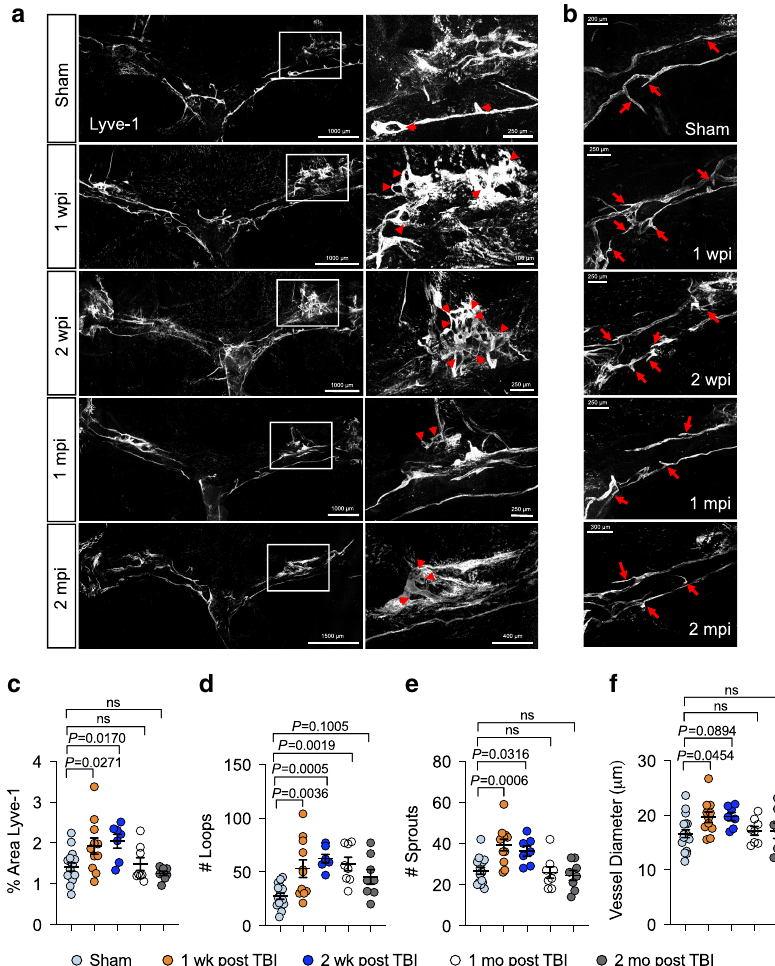
Fig. 2 TBI causes changes in meningeal lymphatic vasculature morphology. Mice received TBI or sham treatment and then meningeal whole mounts were harvested 1 week, 2 weeks, 1 month, and 2 months later. a Representative images depicting transverse sinuses (left) and meningeal lymphatic vasculature loops near lymphatic hotspots (right) and ( c ) quanti fi cation of the percent area coverage of Lyve-1 antibody staining and ( d ) the number of loops in meningeal whole mounts. Solid boxes show zoomed insets of the hotspots along the transverse sinus on the right. Red arrow heads in the insets of ( a ) denote meningeal lymphatic vasculature loops. b Representative images depicting meningeal lymphatic vasculature sprouts along the transverse sinuses and ( e ) quanti fi cation of the number of sprouts found in meningeal whole mounts. Red arrows in ( b ) denote meningeal lymphatic vasculature sprouts. f Quanti fi cation of the diameters of the meningeal lymphatic vessels. Each data point represents an independent mouse and is an average of 70 measurements along the transverse and superior sagittal sinuses per mouse. Data in ( c – f ): Sham n = 15, 1 week n = 11, 2 weeks n = 7, 1 month n = 8, 2 months n = 8; pooled data from four independent experiments. All n values refer to the number of mice used and the error bars depict mean ± s.e.m. P values were calculated by a one-way ANOVA with Dunnett ’ s multiple corrections test ( c – f ). mo month(s), mpi month(s) post injury, wk week(s), wpi week(s) post injury. Source data ( c – f ) are provided as a Source data fi